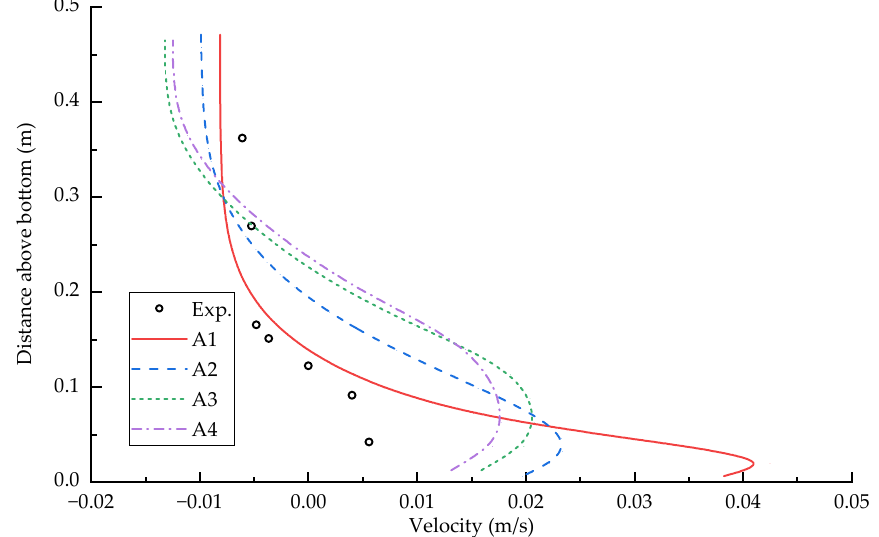
Figure 5. Velocity profile at position 11.43 m from upstream at 11 min for different vertical coordi- nate models.